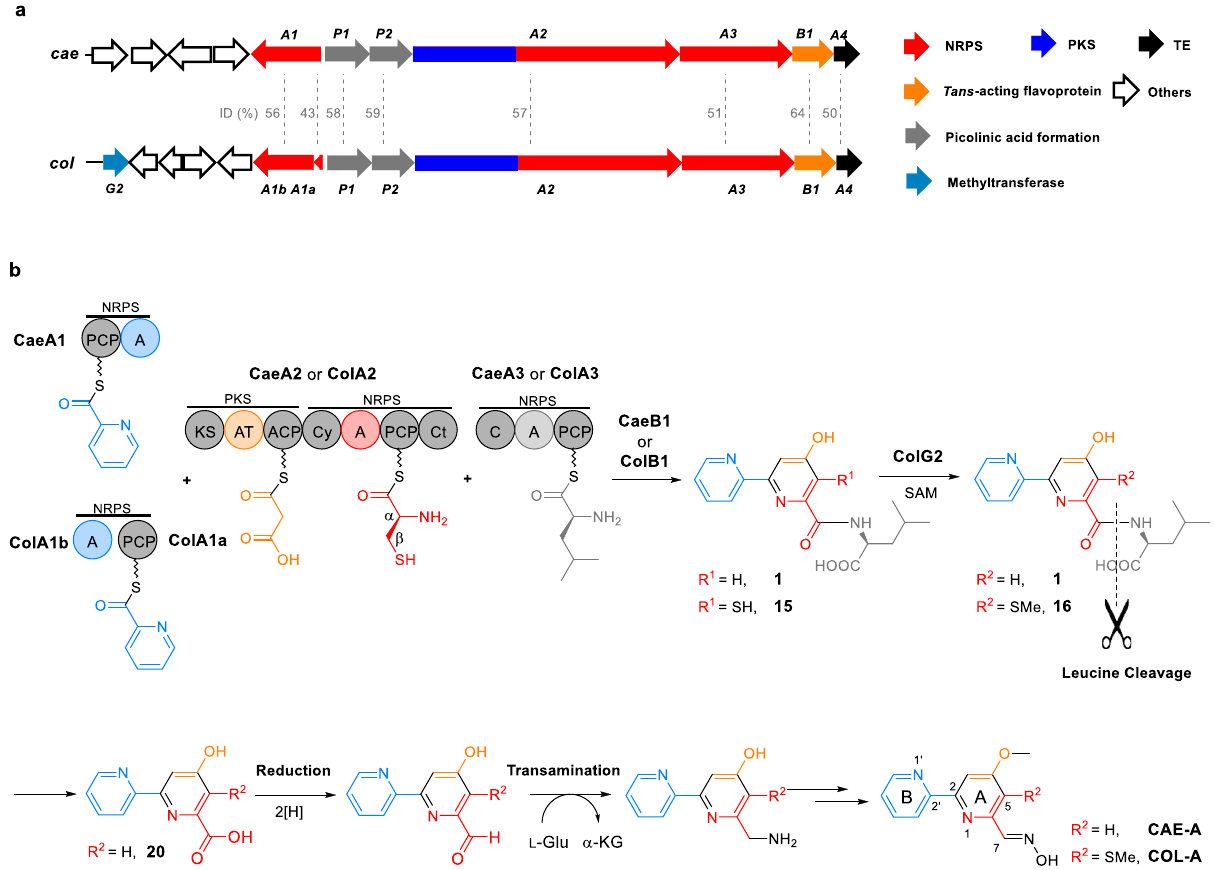
Fig. 1 Biogenesis of the polyketide-peptide hybrid, 2,2 ’ -bipyridine antibiotics CAE-A and COL-A. a Organization of related genes in the CAE and COL biosynthetic gene clusters that codes for the hybrid NRPS/PKS assembly lines, the associated trans -acting fl avoproteins and other proteins. The didomain encoding gene caeA1 in the cae cluster corresponds to the two discrete genes, colA1a and colA1b , in the col cluster. Gene functions are annotated by color on the left. ID, sequence identity. b Hybrid NRPS/PKS assembly line for 2,2 ’ -bipyridine formation. PKS and NRPS modules are indicated. The functional domains (i.e., AT and A domains) for substrate speci fi city are indicated in different colors with their associated building blocks: blue for picolinyl, yellow for malonyl, red for L -cysteinyl, and light gray for L